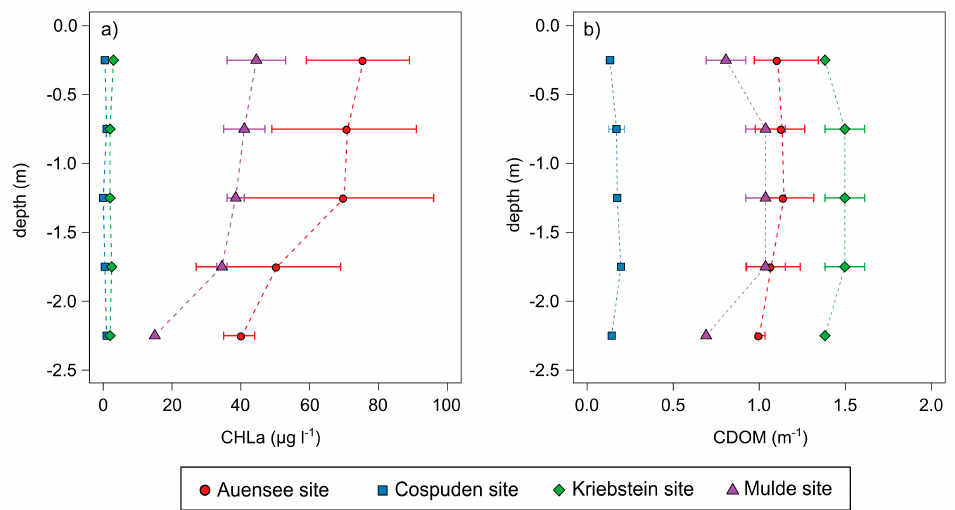
Figure 6. Vertical distribution of CHLa ( a ) and CDOM ( b ) for the investigated lake sites. Points mark the layer-specific mean, solid lines mark the layer-specific range of measured reference values.